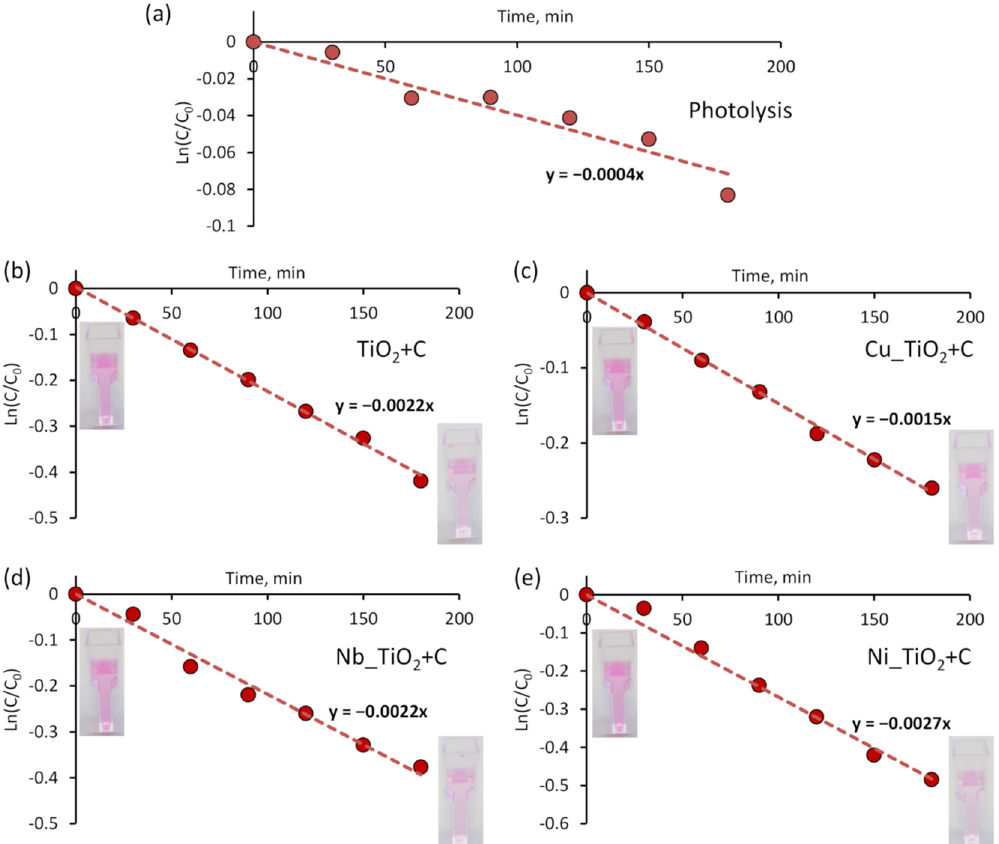
Figure 5. Photocatalytic bleaching of Rhodamine B under VL light irradiation ( a ) without sample and using various C-doped TiO 2 film underlayers; ( b ) no underlayer; ( c ) Cu underlayer; ( d ) Nb underlayer; and ( e ) Ni underlayer.